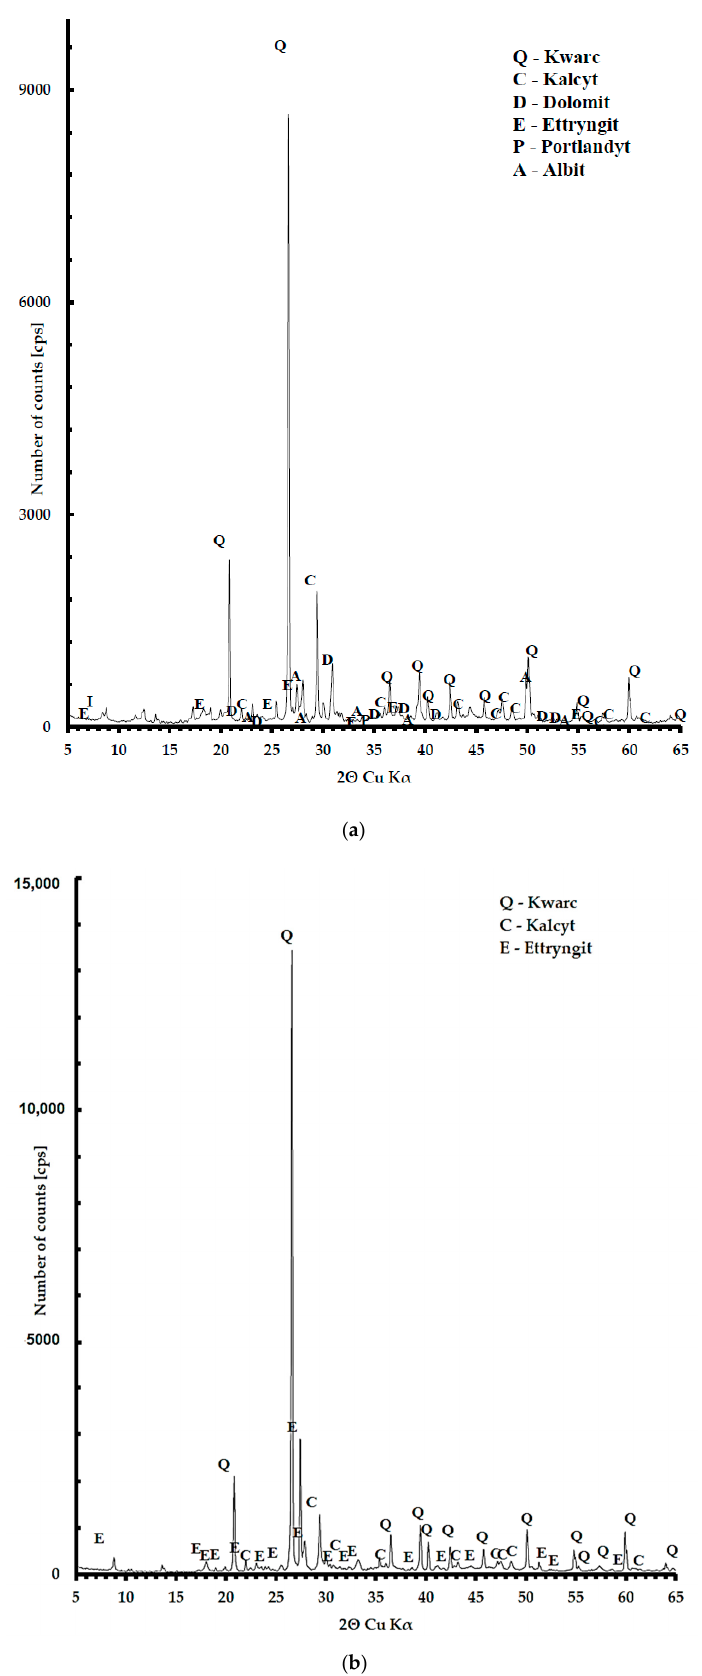
Figure 13. XRD analysis for C-7.5: ( a ) diffractogram, 20 °C; ( b ) diffractogram, 800 °C.